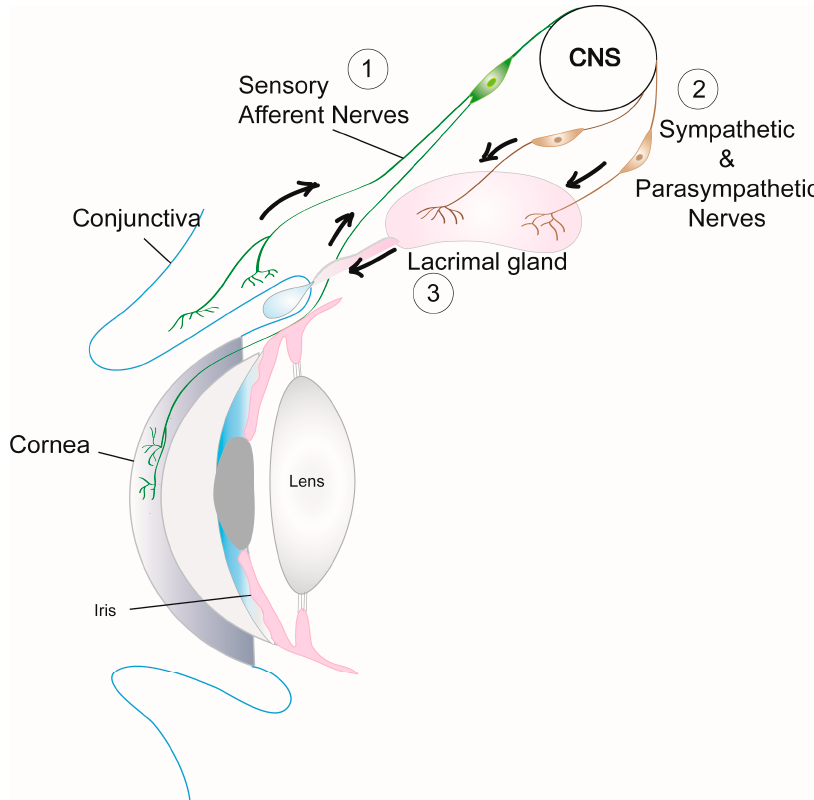
Figure 2. Neural regulation of the lacrimal functional unit. Schematic of the components of lacrimal Figure 1. impulses transmitted from the cornea and conjunctiva via sensory afferent nerves are received in the central nervous system (CNS) to stimulate (2) efferent sympathetic and parasympathetic nerves that innervate LG cellular components (acinar and duct epithelial cells and MECs) resulting in (3) secretion of tear fluid containing proteins, electrolytes, and water that is delivered onto the ocular surface through the duct system.